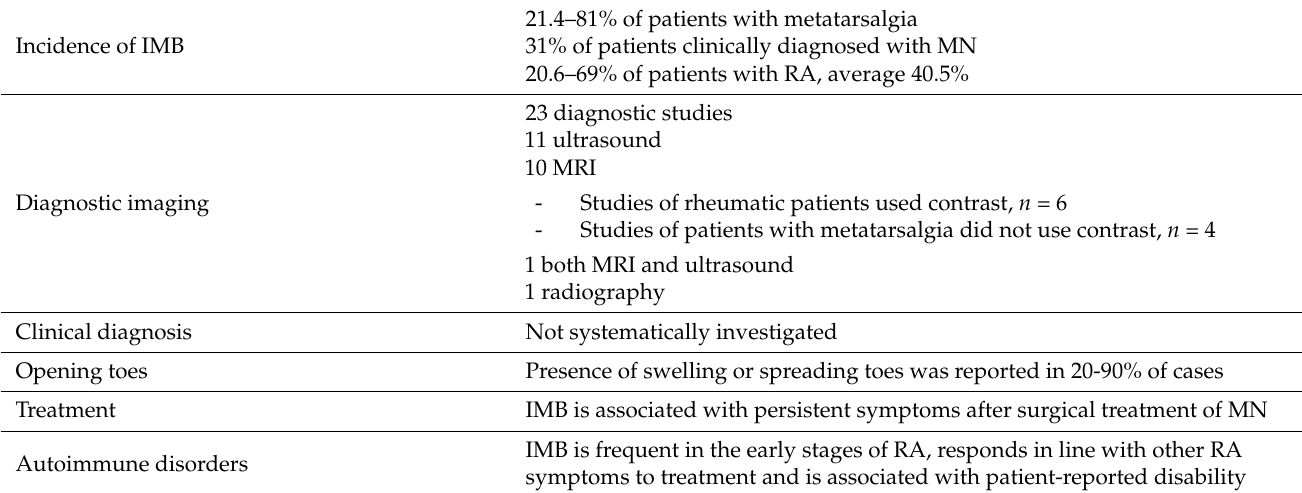
Table 2. Summary of